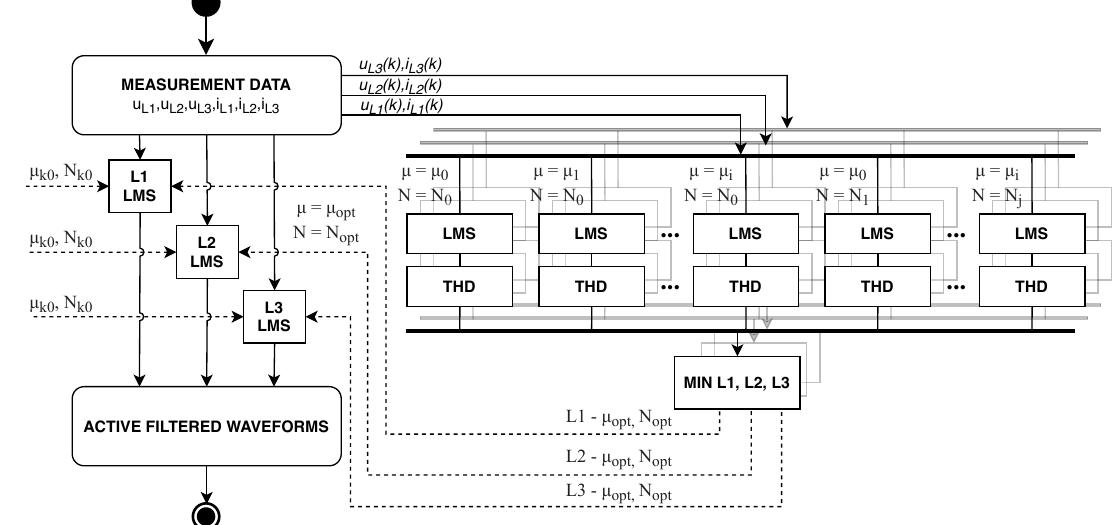
Figure 19. Diagram of optimization experiment of LMS algorithm setting.